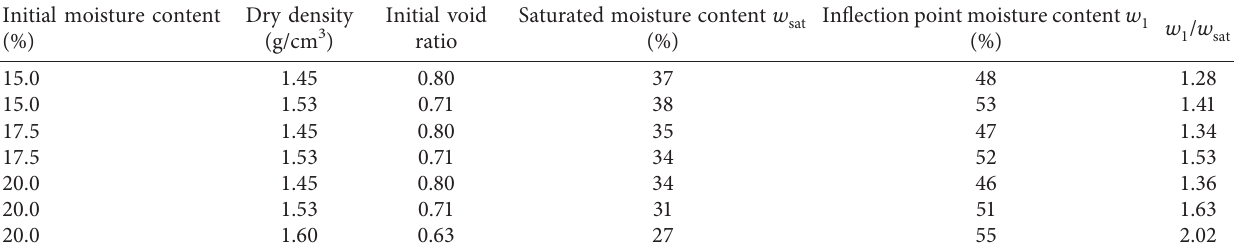
Table 2: Saturated soil moisture content of expansive soil under different initial